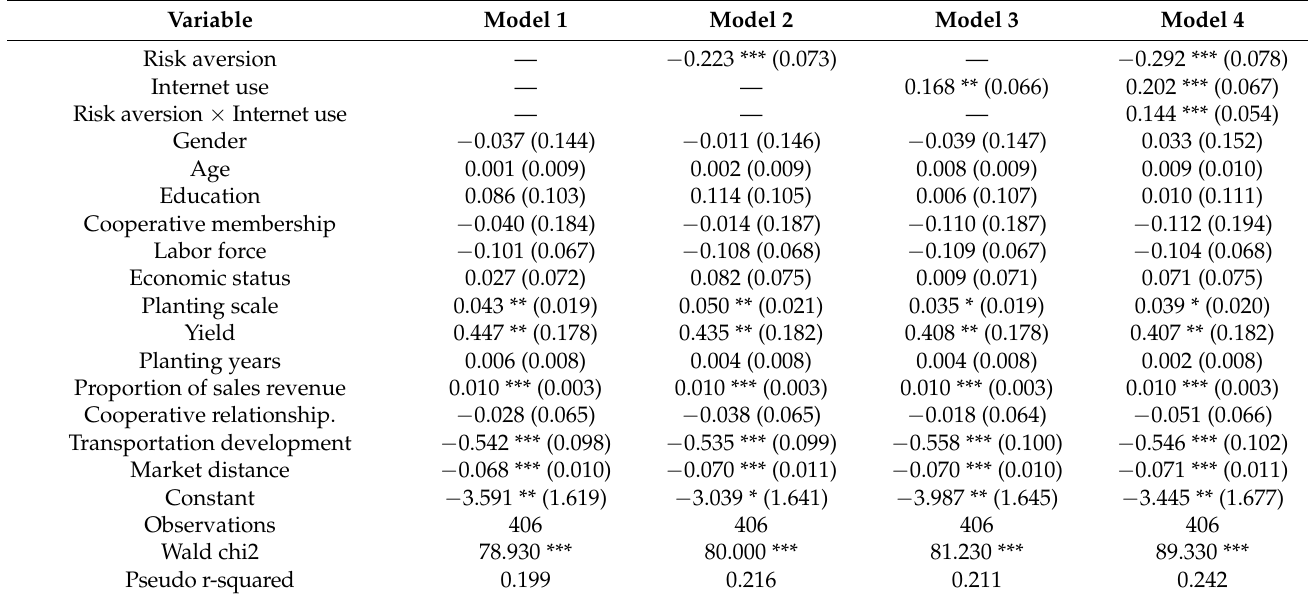
Table 5. Benchmark regression